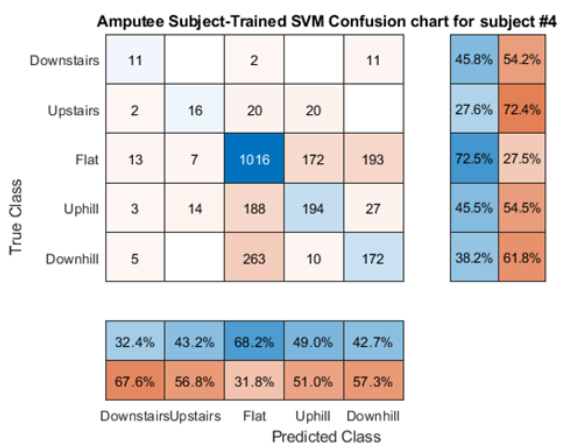
Figure A14. Support Vector Machine Confusion Chart for ILLA participant A4 as trained by all other ILLA participants